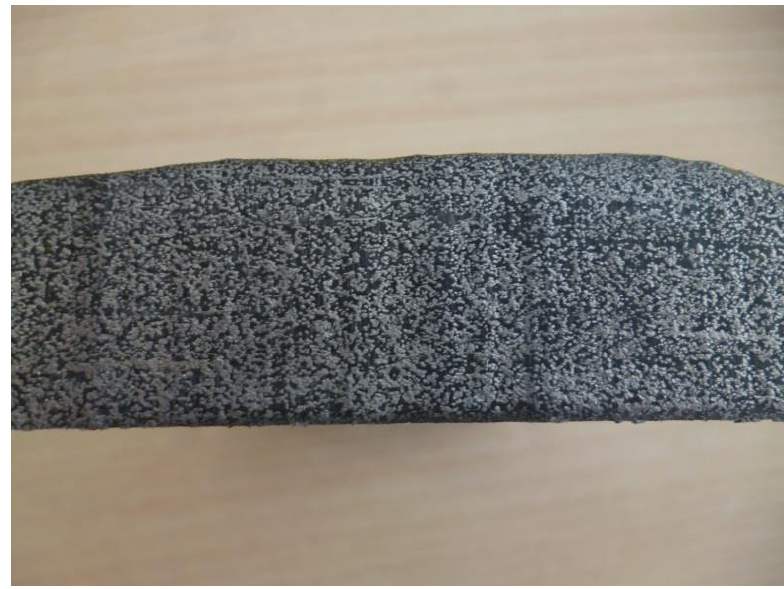
Figure 1. Epoxi resin-metal wool composite produced via vacuum infiltration.